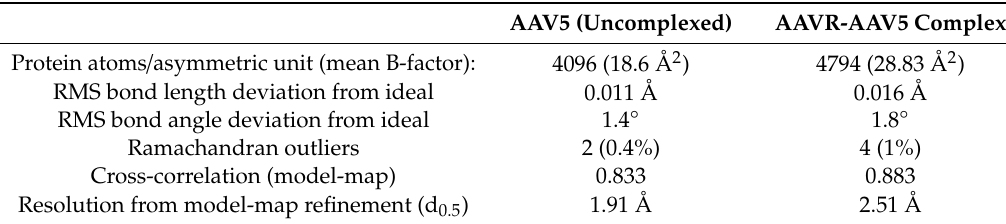
Table 2. Refinement of the atomic